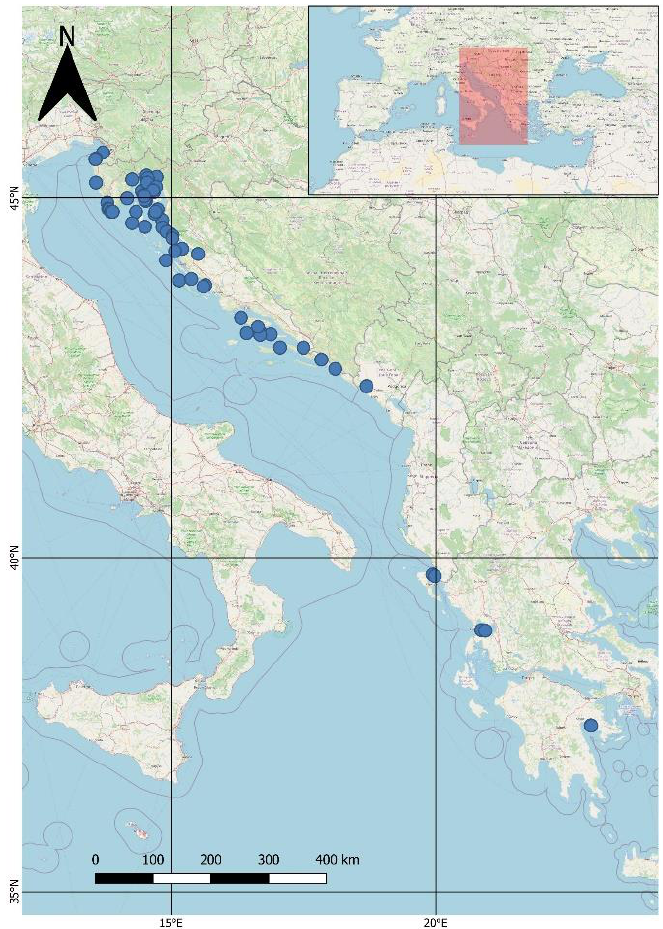
Figure 4. Records of Gobius bucchichi in the Adriatic Sea and Ionian Sea.